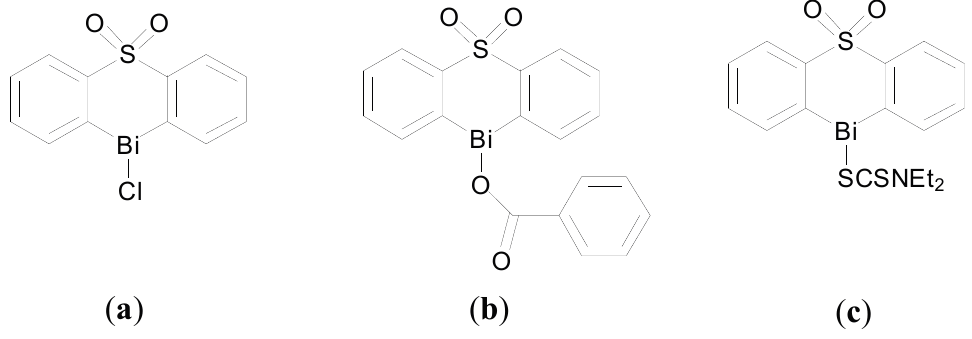
Figure 11. Structures of heterocyclic organobismuth(III) compounds derived from diphenyl sulfone. ( a ) Chlorobismuthane; ( b ) A carboxylate bismuthane; ( c ) A dithiocarbamate